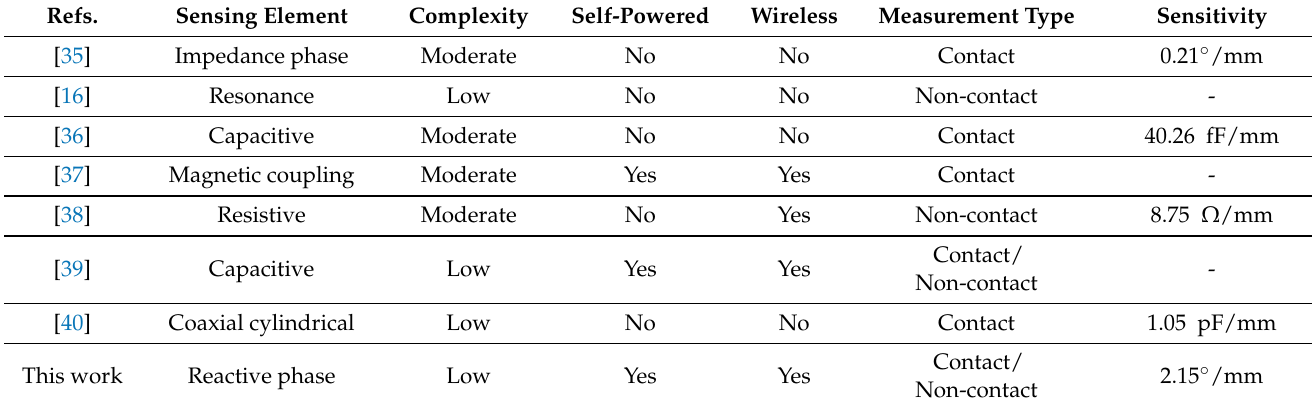
Table 1. Comparison of the proposed wireless sensor with other liquid-level detection sensors.